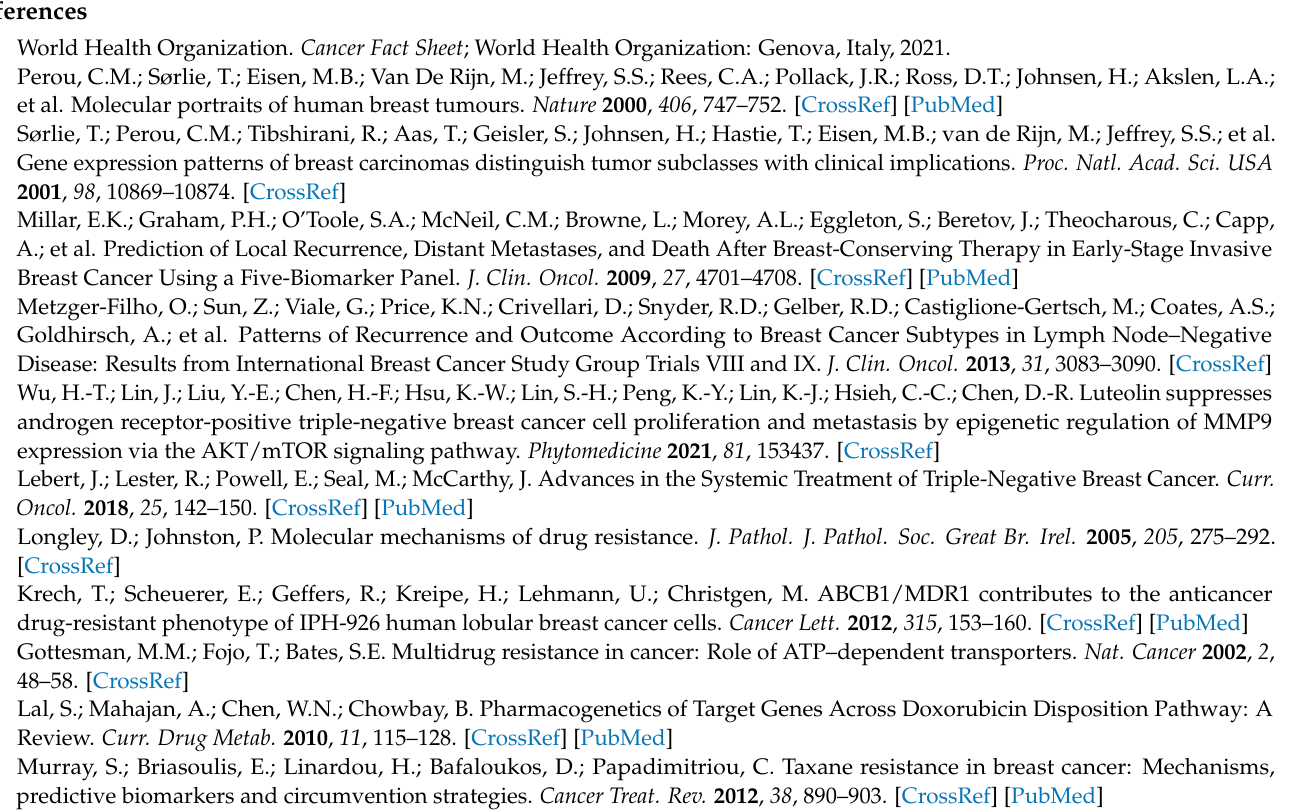
migration and invasive activities of chemo-drug-resistant MDA-MB-468 cells. Figure S6: Correlation between USP7 and ABCB1 in vivo.; Table S1: List of proteins tested by and characteristics of the corresponding antibodies. Table S2: Sequence of the oligonucleotides for Quantitative real-time PCR assays. Table S3: List of plasmid constructs